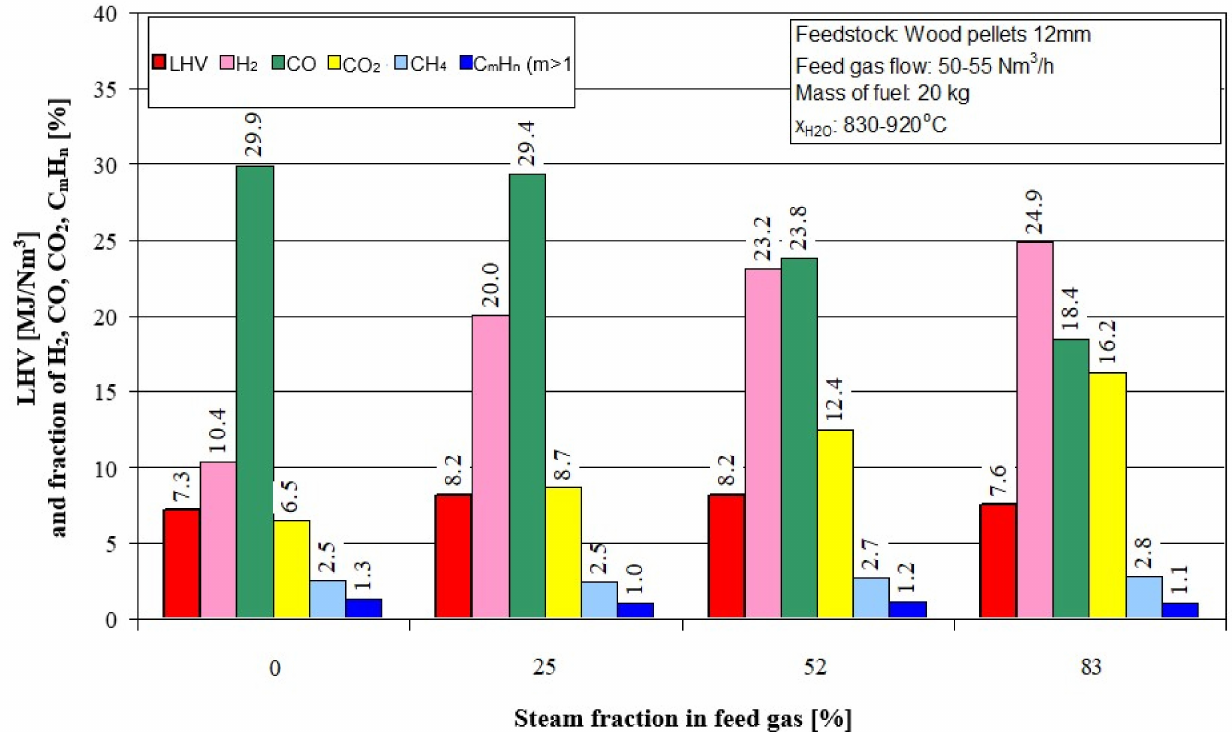
Figure 5. Influence of the steam fraction on the average values of composition and Lower Heating Value (LHV) of the gas fuel—gasification of 20 kg wood pellets with a diameter of 12